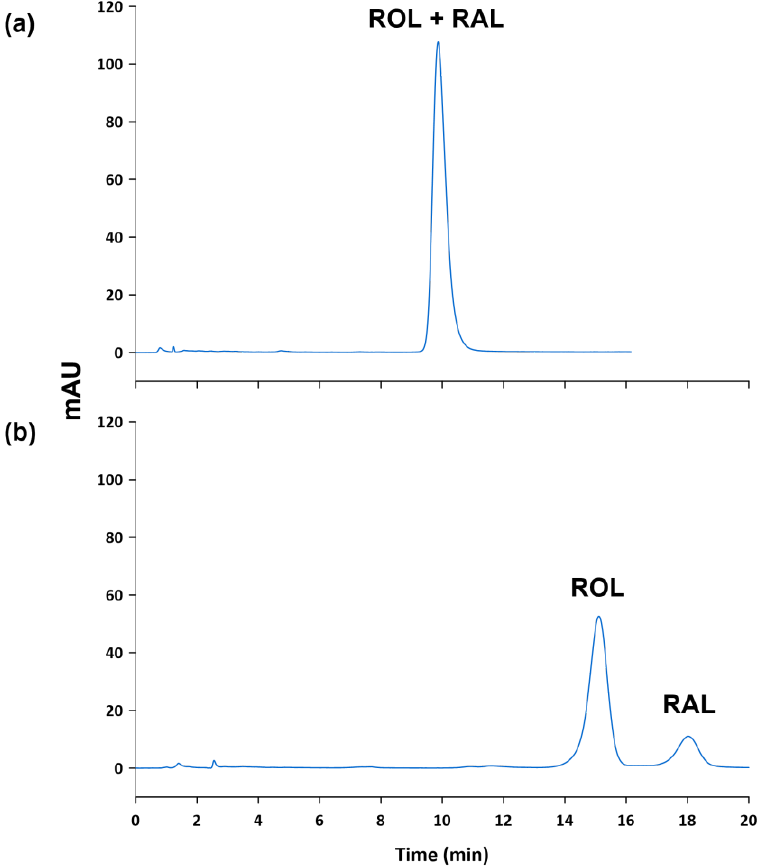
Figure 2. Chromatograms of a standard solution containing ROL and RAL at 10 µg mL −1 obtained using a ( a ) LiChrospher ® 60 Select-B (125 mm × 4 mm, 5 µm), and ( b ) a LiChrospher ® 60 Select-B using a ( a ) LiChrospher ® 60 Select-B (125 mm × 4 mm, 5 µ m), and ( b ) a LiChrospher ® 60 Select-B (250 mm × 4 mm, 5 µm). (250 mm × 4 mm, 5 µ